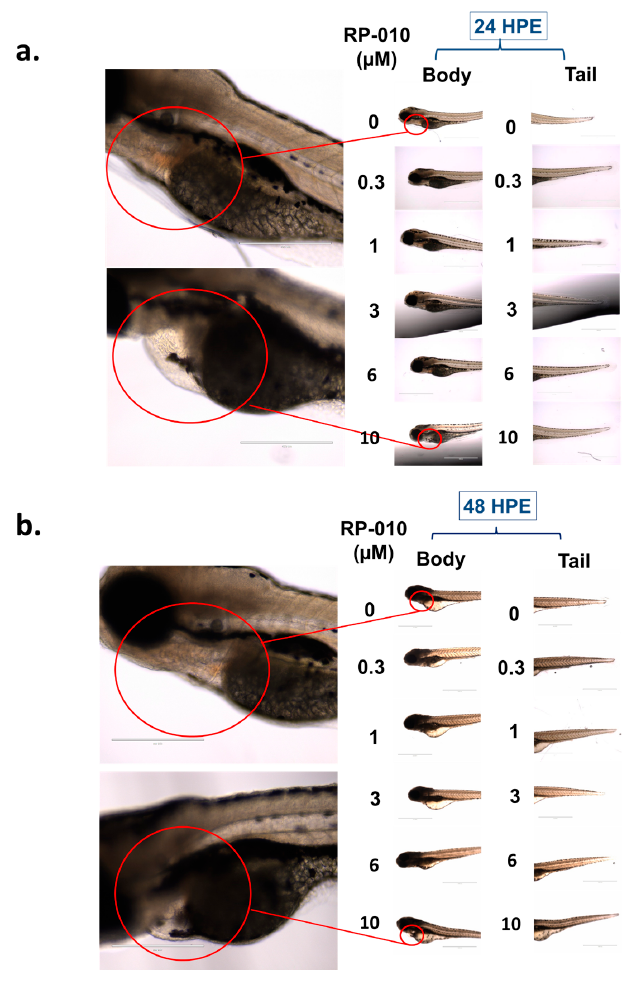
Figure 6. RP-010 toxicity in an in vivo zebrafish model. The effect of RP-010 (0, 0.3, 1, 3, 6, or 10 µM), or vehicle treatment, on the bodies (left) and tails (right) of zebrafish, after ( a ) 24- or ( b ) 48-h drug exposure. Scale bar: Images were taken at 4× (scale bar: 1000 µm) and zoomed to 10× (scale bar: 400 µm).